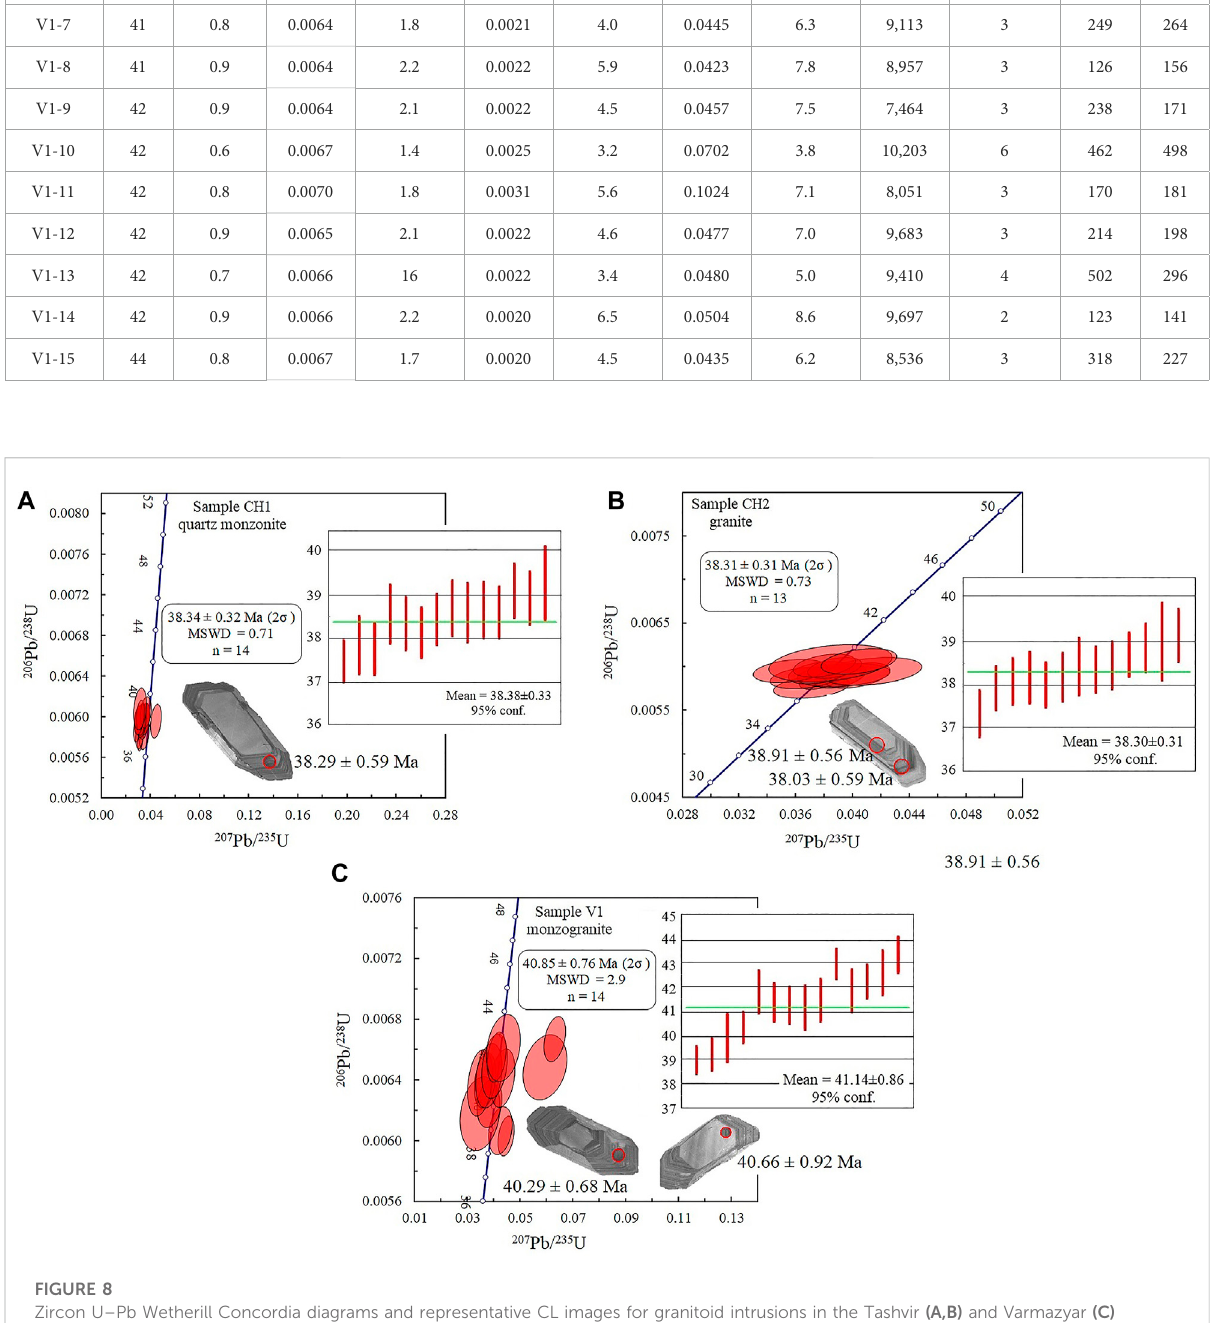
Frontiers in Earth